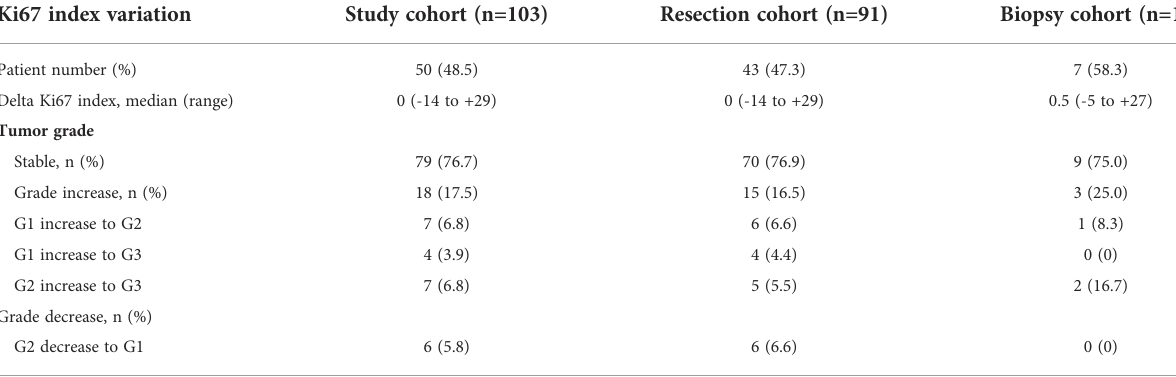
Table 2. Ki67 index variation and grade changes in metastases compared to primary tumors in PanNETs. Ki67 index